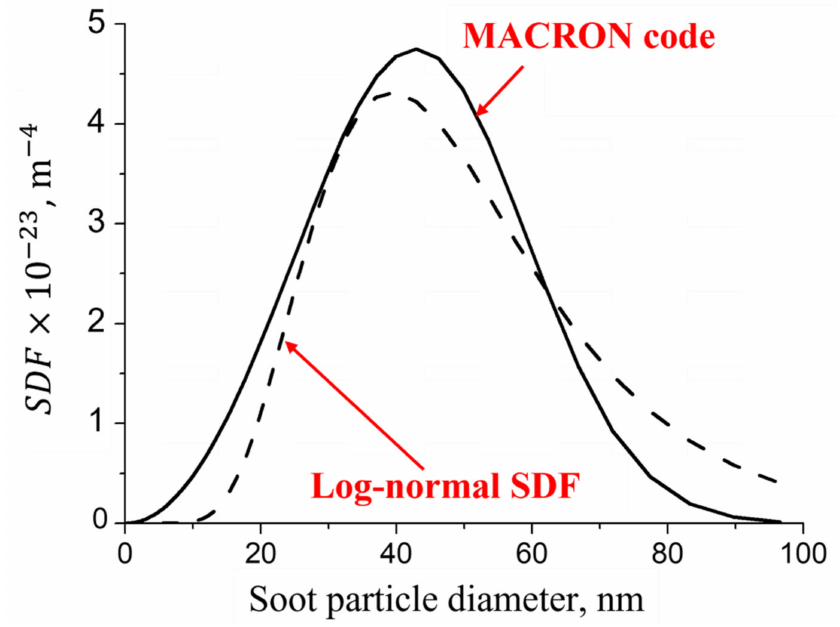
Figure 4. Illustration of the approximation accuracy of the soot-particle SDF obtained using MACRON code calculation with the log-normal SDF of Equation (15). Fuel: n-C 14 H 30 , Φ = 4, p = 100 atm, T = 2200 K, EGR = 0.6, and τ = 3.0